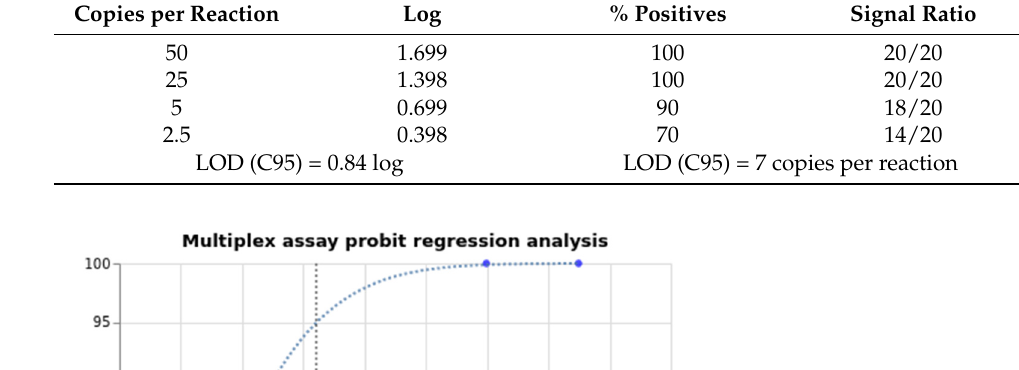
Table 1. Serial dilution analysis with the multiplex RT-qPCR assay.